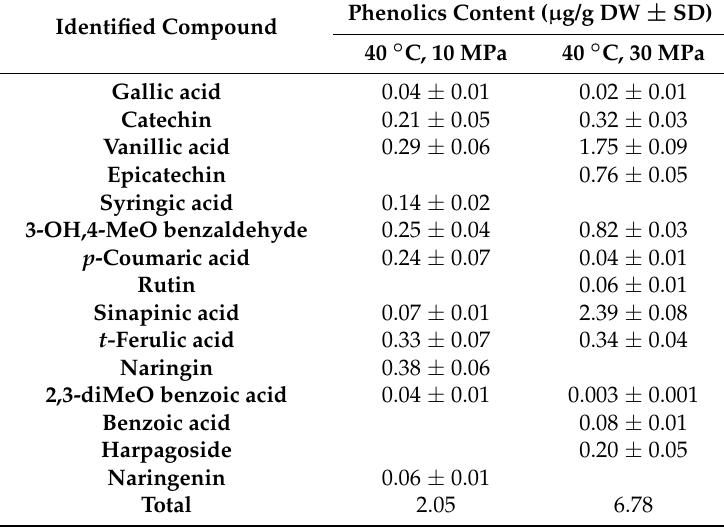
Table 2. Qualitative and quantitative phenolics profile of Atriplex mollis aerial part extracts by supercritical fluid